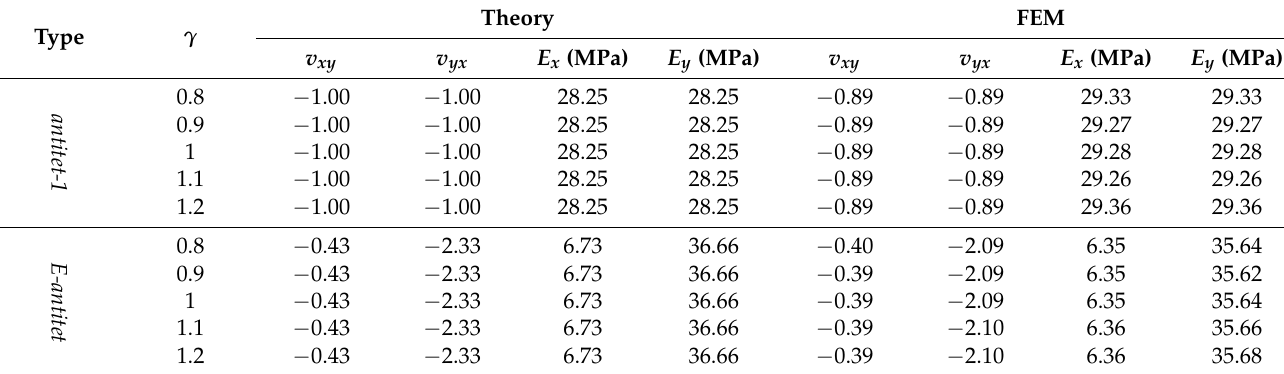
Table A6. Detailed results of Poisson’s ratio and Young’s modulus of E-antitet at different γ